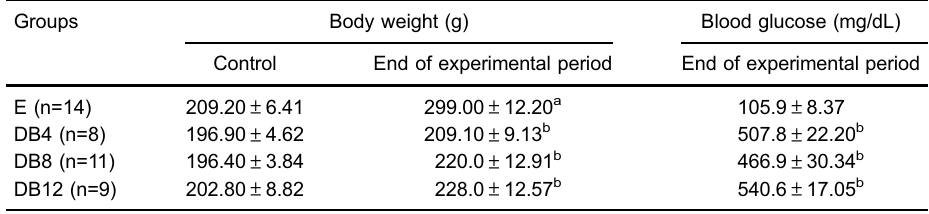
Table 1. Changes in body weight and blood glucose levels of diabetic and control rats.